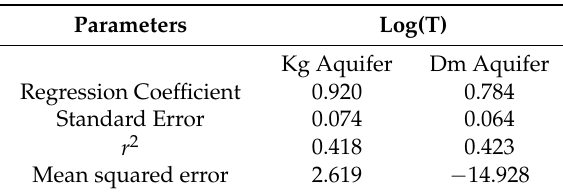
Table 3. Cross validation results of Kg and Dm